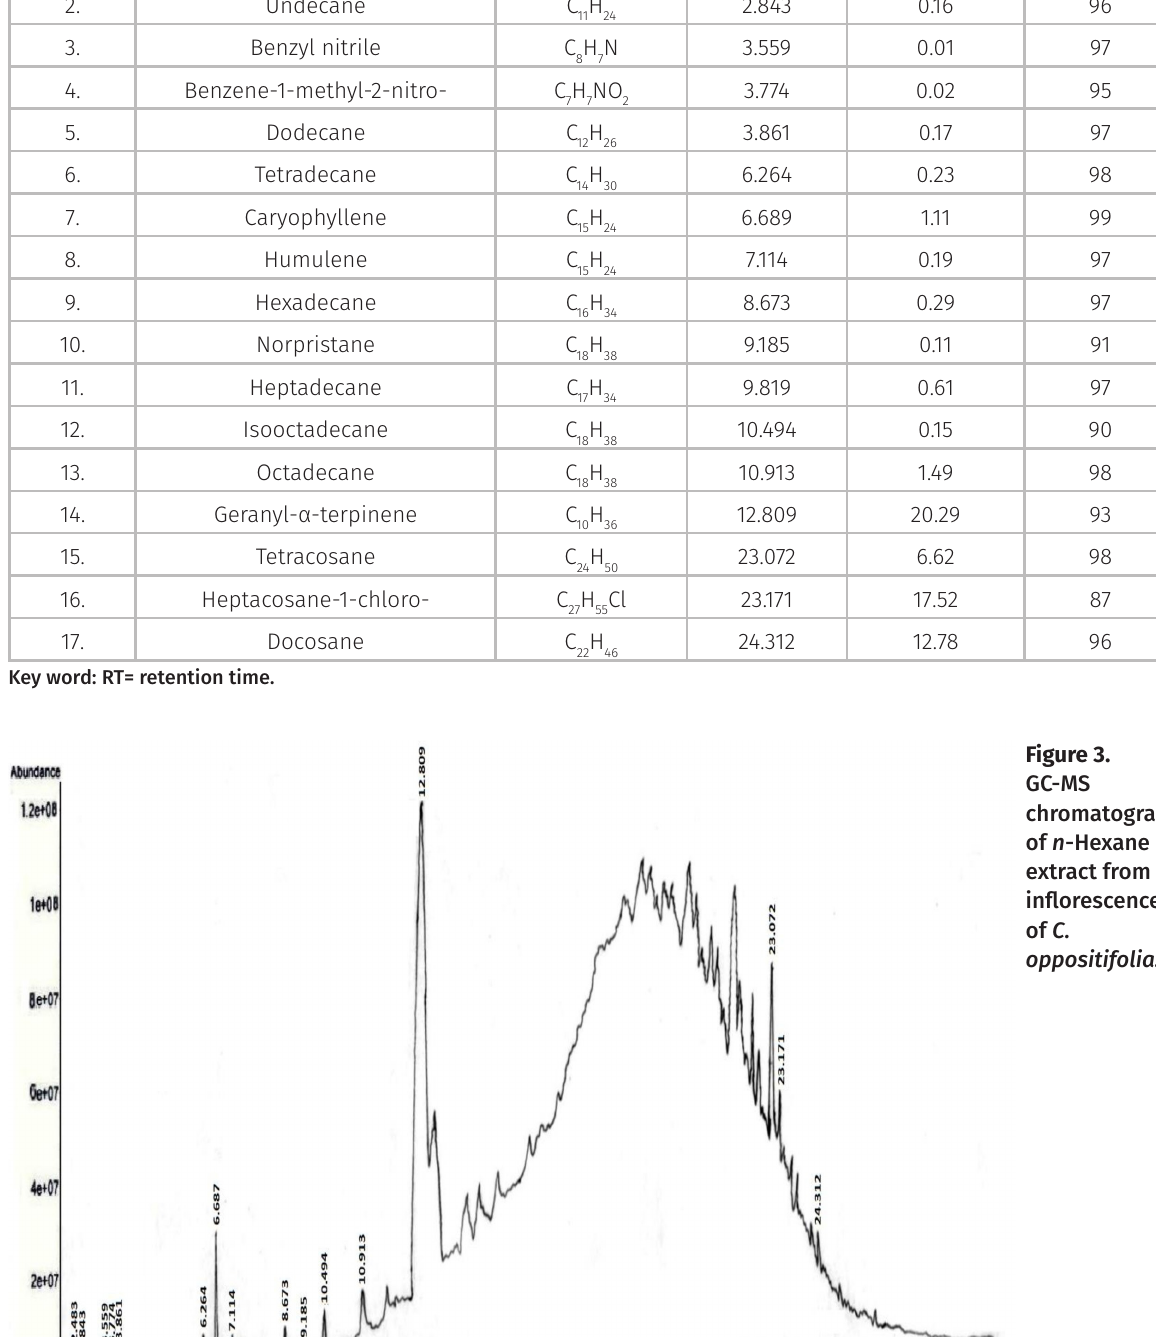
Table III. GC-MS table of C. oppositifolia inflorescence, for identified compounds. Sr. No.